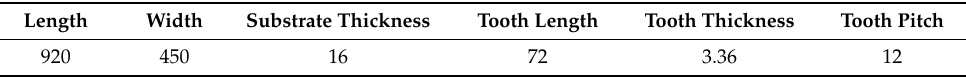
Table 4. Material properties of each layer.